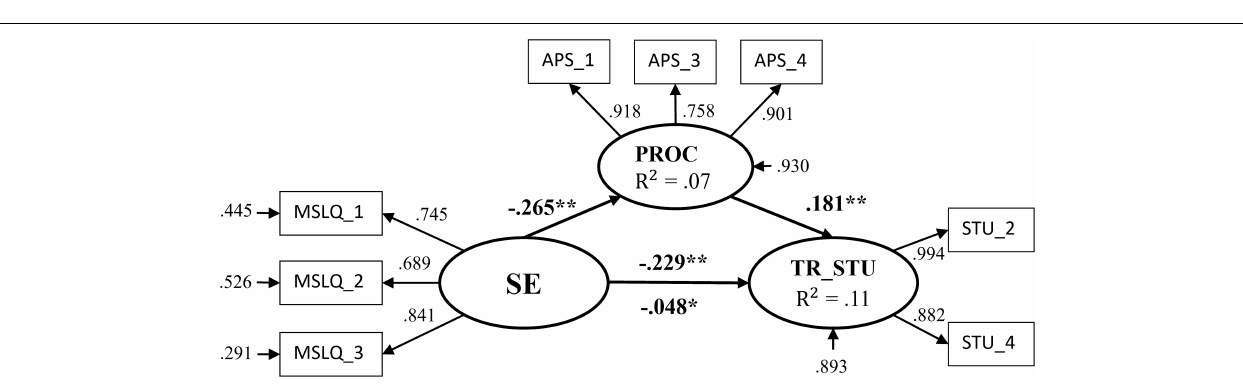
FIGURE 2 | Mediation model for transfer university intentions ( n = 693). Indirect effect is provided below the path line. SE, Academic self-efficacy; PROC, procrastination; TR_UNI, transfer university intentions. * p ≤ 0.01, ** p ≤ 0.001.